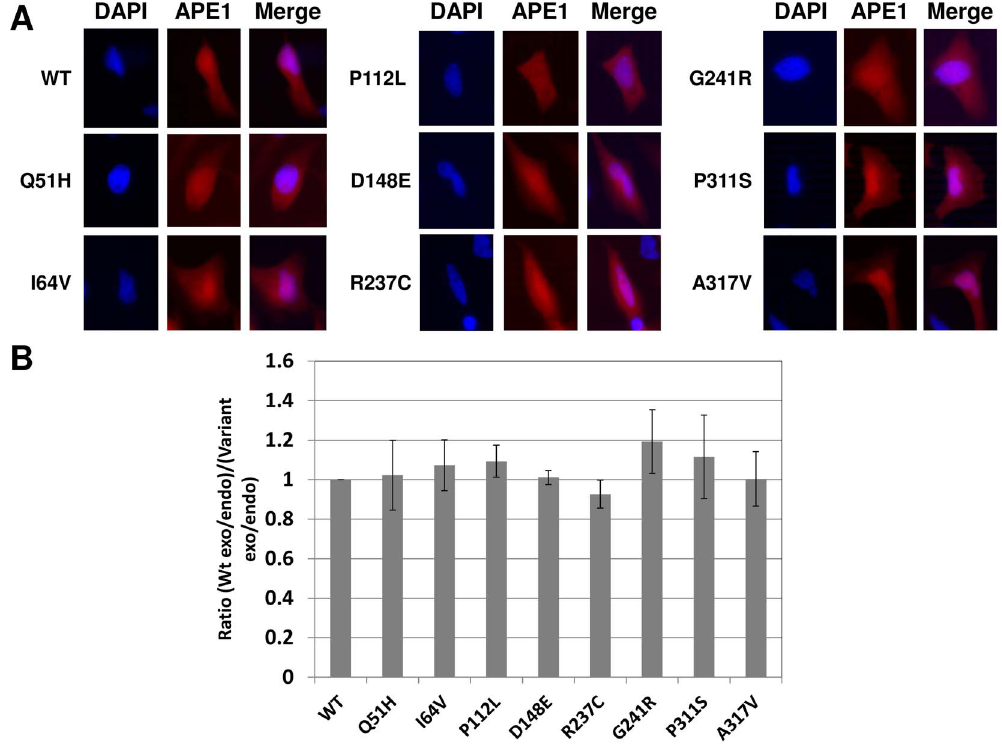
Figure 7. Intracellular localization of APE1 protein variants. ( A ) Representative microscopy images of the mCherry APE1 fusion proteins following plasmid transfection into HeLa cells. Shown are the DAPI nuclear staining, mCherry fusion protein fluorescence and the merged images. ( B ) Comparative cytoplasm to nuclear distribution for the different mCherry APE1 proteins. Using densitometry, the ratio of exogenous cytoplasmic mCherry-tagged wild-type (WT) APE1 protein to endogenous cytoplasmic protein was divided by the ratio of exogenous nuclear mCherry-tagged WT APE1 protein to endogenous nuclear protein, and this value was designated as 1. The identical ratio was then determined for each of the APE1 variant proteins, and plotted relative to the WT value. Shown is the average and standard deviation of results from 3 separate extract preparations and western blot experiments.